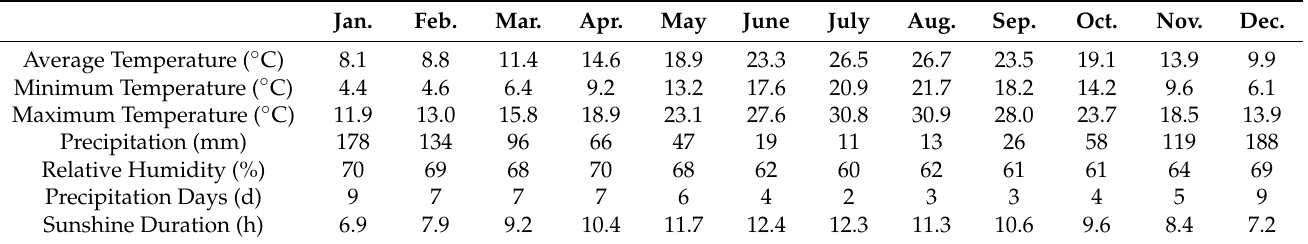
Table 1. Meteorological characteristics of the Alanya